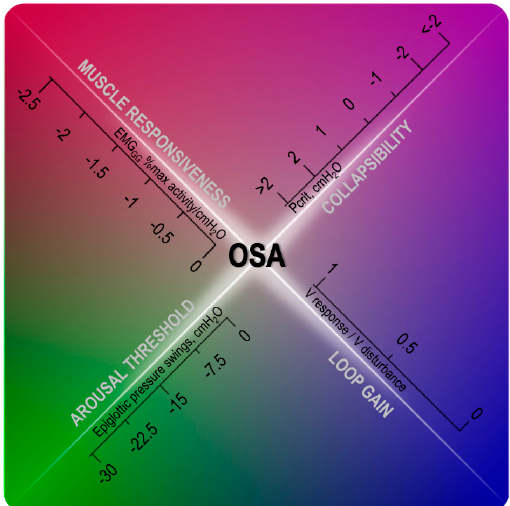
Figure 1. Diagram showing the interaction of four endotypic traits on obstructive sleep apnea (OSA) pathogenesis: in the presence of mild-to-moderate collapsibility, indicated by a critical collapsing pressure (Pcrit) between − 2 and 2 cmH 2 O, other non-anatomical traits play a role in OSA pathophysiology. The inability to recruit the upper airway dilator muscle in response to negative pharyngeal pressure swings during an obstructive event (% activity/cmH 2 O close to 0), a low arousal threshold (epiglottic pressure swings before the arousal above − 15 cmH 2 O) and a high loop gain (close to or above 1) will contribute in different degrees to OSA development. Note that the boundaries between the four traits are intentionally blurred to show that OSA presence and severity is often determined by the interaction of these pathogenic traits. EMG GG : genioglossus electromyography, V response / V disturbance: ratio between the ventilatory response to a preceding ventilatory disturbance,